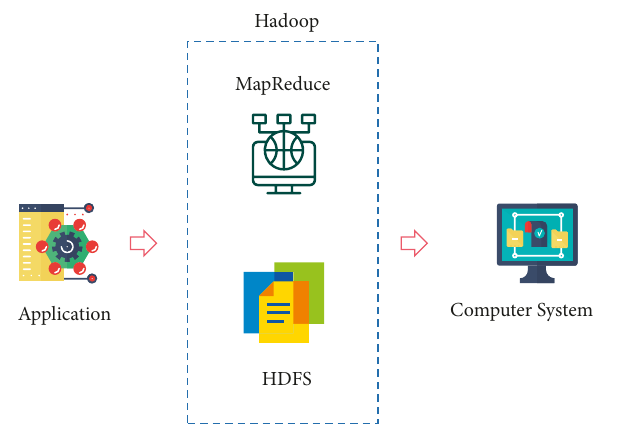
Figure 1: Hadoop